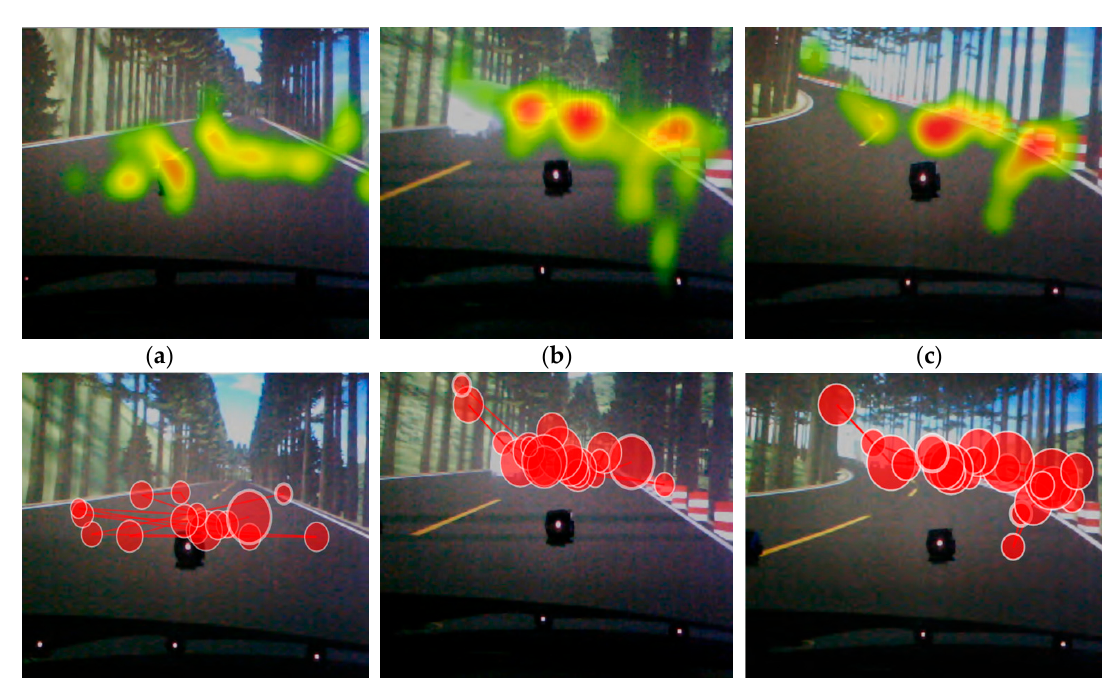
Figure 11. The heat maps and gaze plot maps of drivers’ eye-movement characteristics in anxiety. ( a ) Heat map of fixation count before the change-point occurs; ( b ) Heat map of fixation count before the change-point occurs; ( c ) Heat map of fixation count after change-point 2 occurs; ( d ) Trajectory map of fixation duration before the change-point occurs; ( e ) Trajectory map of fixation duration after change-point 1 occurs; ( f ) Trajectory map of fixation duration after change-point 2